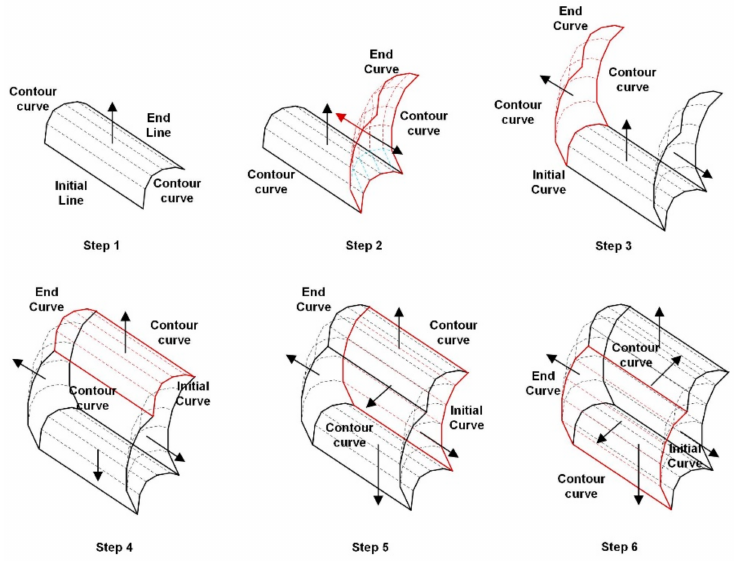
Figure 2. Structure of the surfaces represented in the